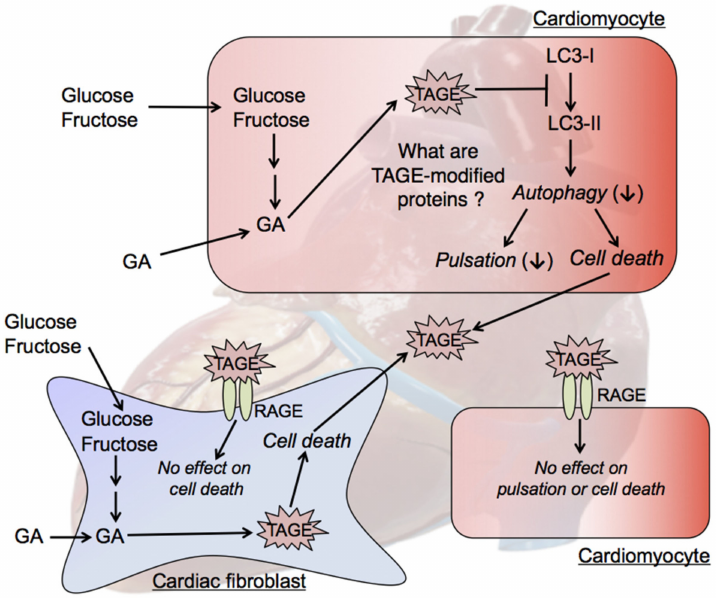
Figure 5. TAGE cytotoxicity against cardiomyocytes and cardiac fibroblasts. GA accumulation in cardiomyocytes leads to TAGE-induced modifications in cellular components, including proteins. TAGE may be released from dead cardiomyocytes; however, extracellular TAGE do not suppress cardiomyocyte pulsation or induce cell death in cardiomyocytes via the TAGE-RAGE axis. The intra- cellular generation of TAGE in cardiac fibroblasts and their cytotoxicity, and the effects of extracellular TAGE on cardiac fibroblasts have not yet been elucidated. GA: glyceraldehyde; LC3 (MAP1LC3): microtubule-associated protein light chain 3; RAGE: receptor for AGEs; TAGE: toxic